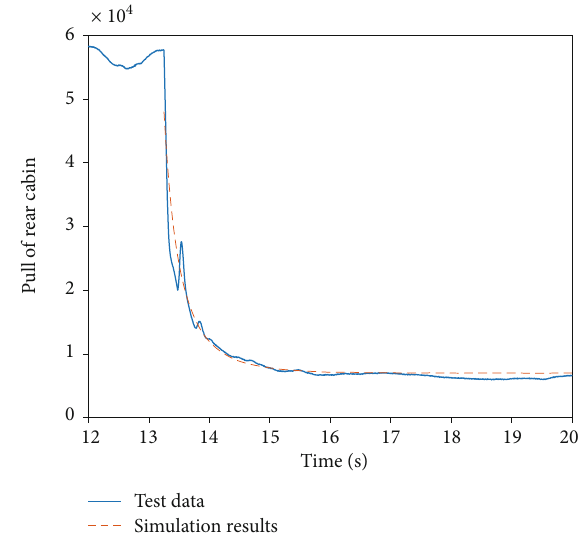
Figure 17: Pull of rear cabin-time